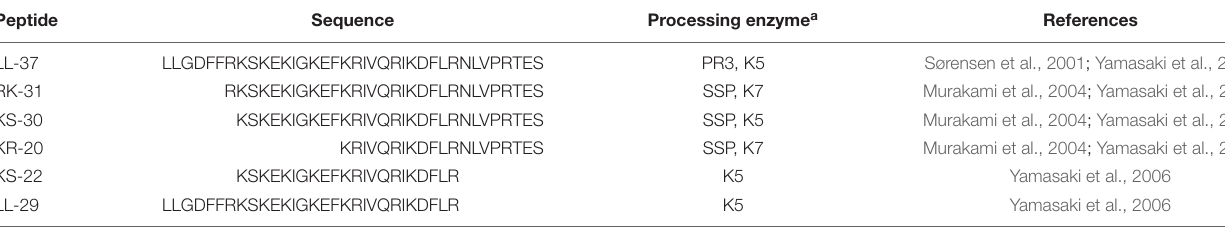
TABLE 1 | Naturally produced LL-37 fragments and their processing enzymes. Peptide Sequence Processing enzyme